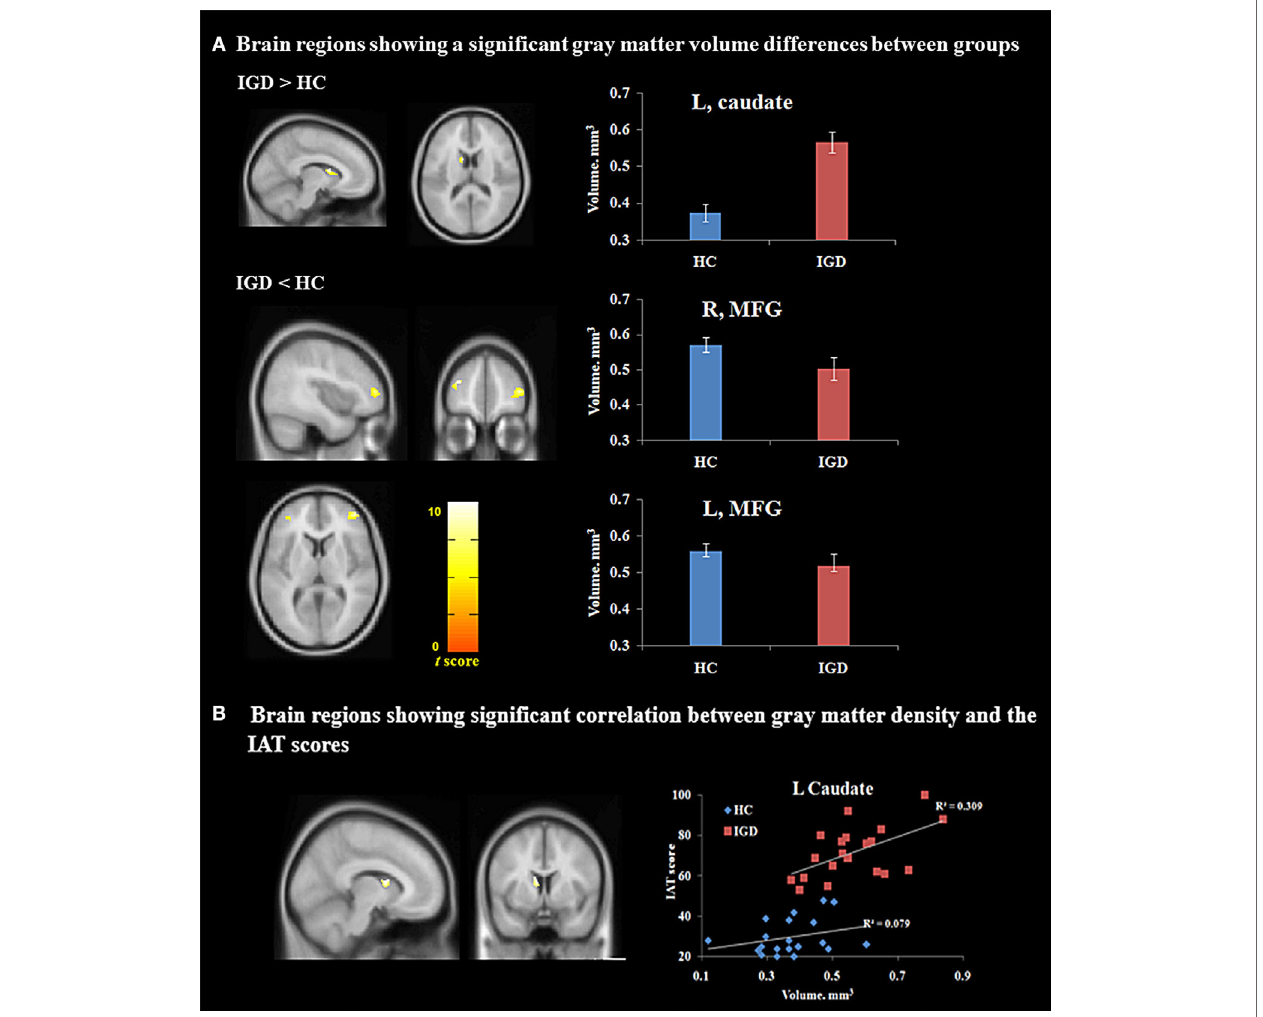
FigUre 1 | Voxel-based morphometry (VBM) analysis. (a) Different gray matter volumes between the IGD group and HC ( p < 0.05, false discovery rate-corrected) (MNI coordinates: L caudate, − 8, 14, 10; R MFG, 44, 51, 8; L MFG, − 37, 45, 20). (B) VBM correlation analysis ( p < 0.01) (MNI coordinates: L caudate, − 9, 8, 15). Abbreviations: HC, healthy controls; IAT, Internet addiction test; IGD, Internet gaming disorder; L, Left; MFG, middle frontal gyrus; R, right; MNI, Montreal Neurological